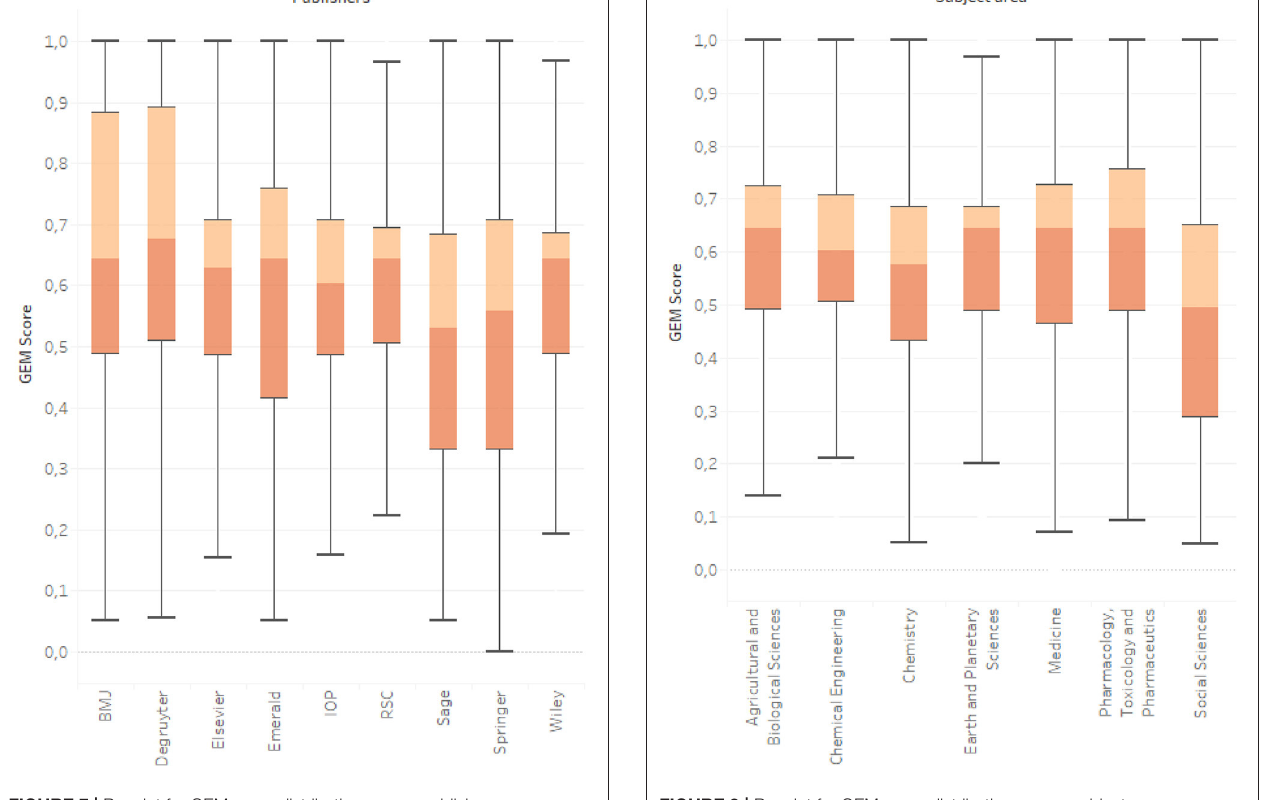
FIGURE 7 | Boxplot for GEM score distribution across publishers. FIGURE 8 | Boxplot for GEM score distribution across subject